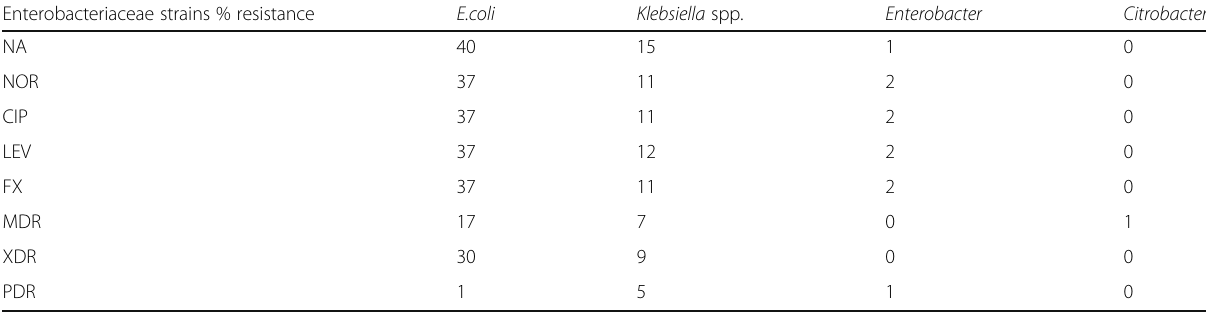
Table 1 Percentage of quinolone resistance, MDR, XDR, and PDR among the isolated Enterobacteriaceae strains Enterobacteriaceae strains % resistance